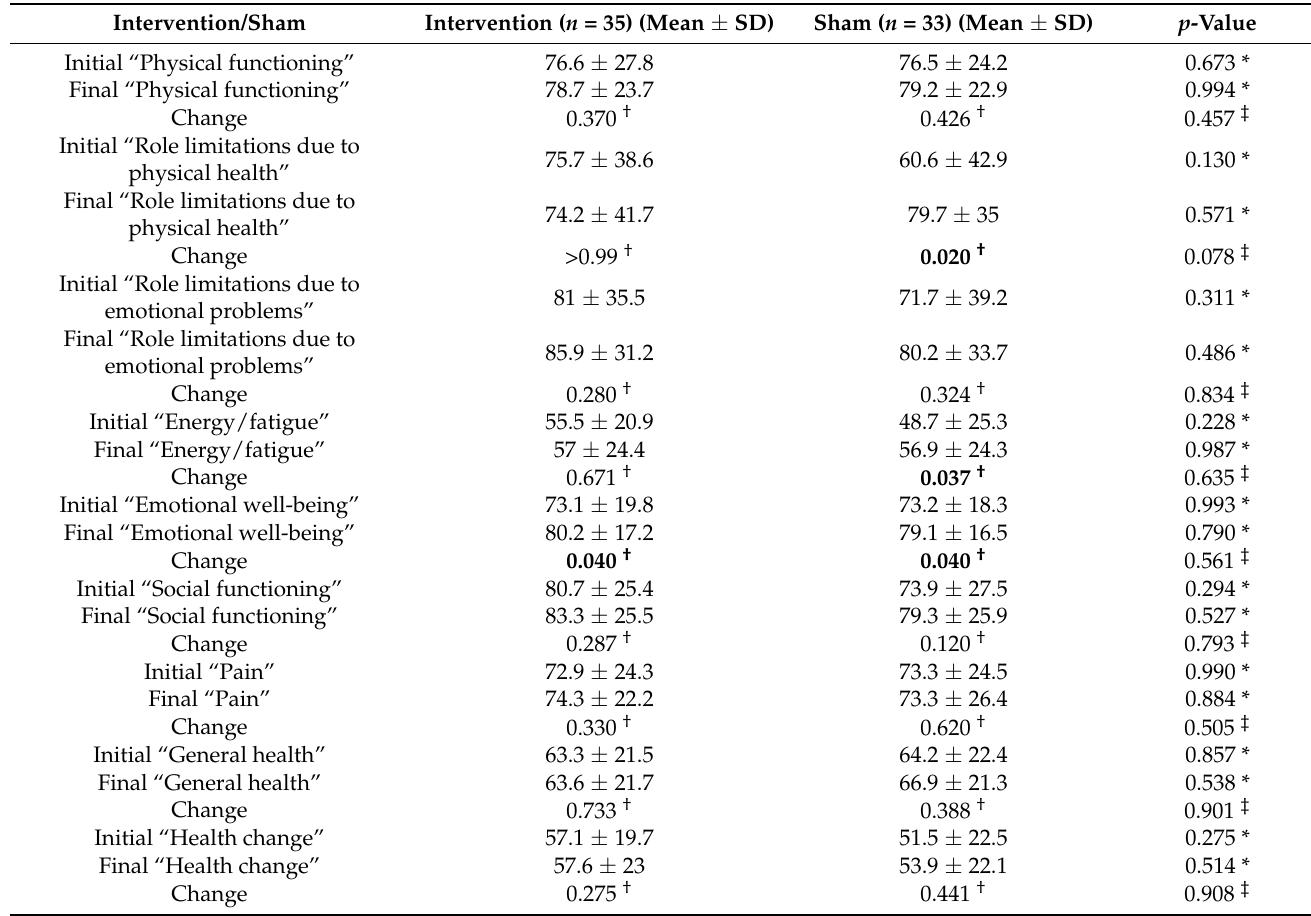
Table 5. Short form survey (SF-36) scoring results in intervention and Sham